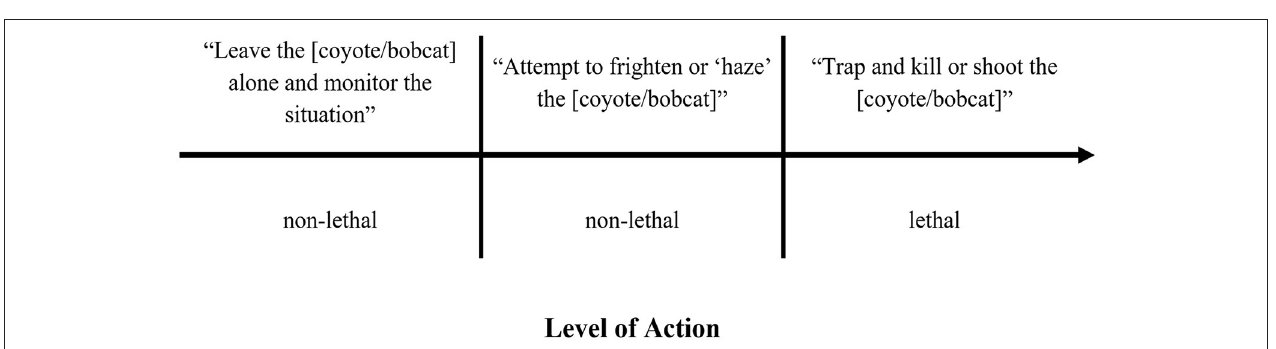
FIGURE 1 | Carnivore scenarios that respondents could receive.